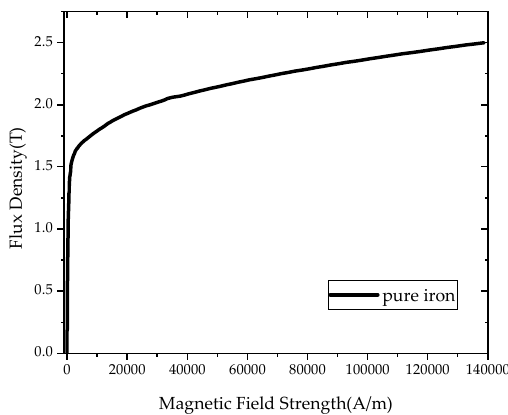
Figure 5. Magnetic property of pure iron.